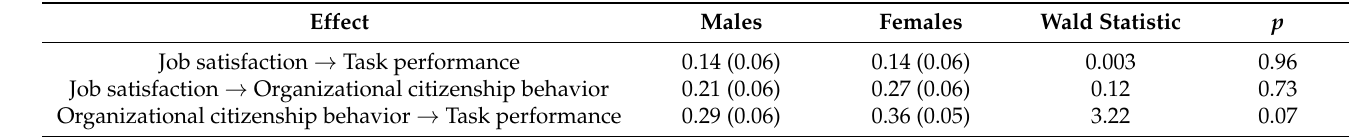
Table 5. Multi-group analyses on the moderating role of gender.